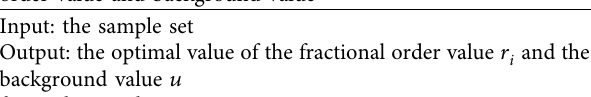
Table 1: The pseudo code of PSO. Algorithm. Particle swarm optimization to solve the fractional order value and background value